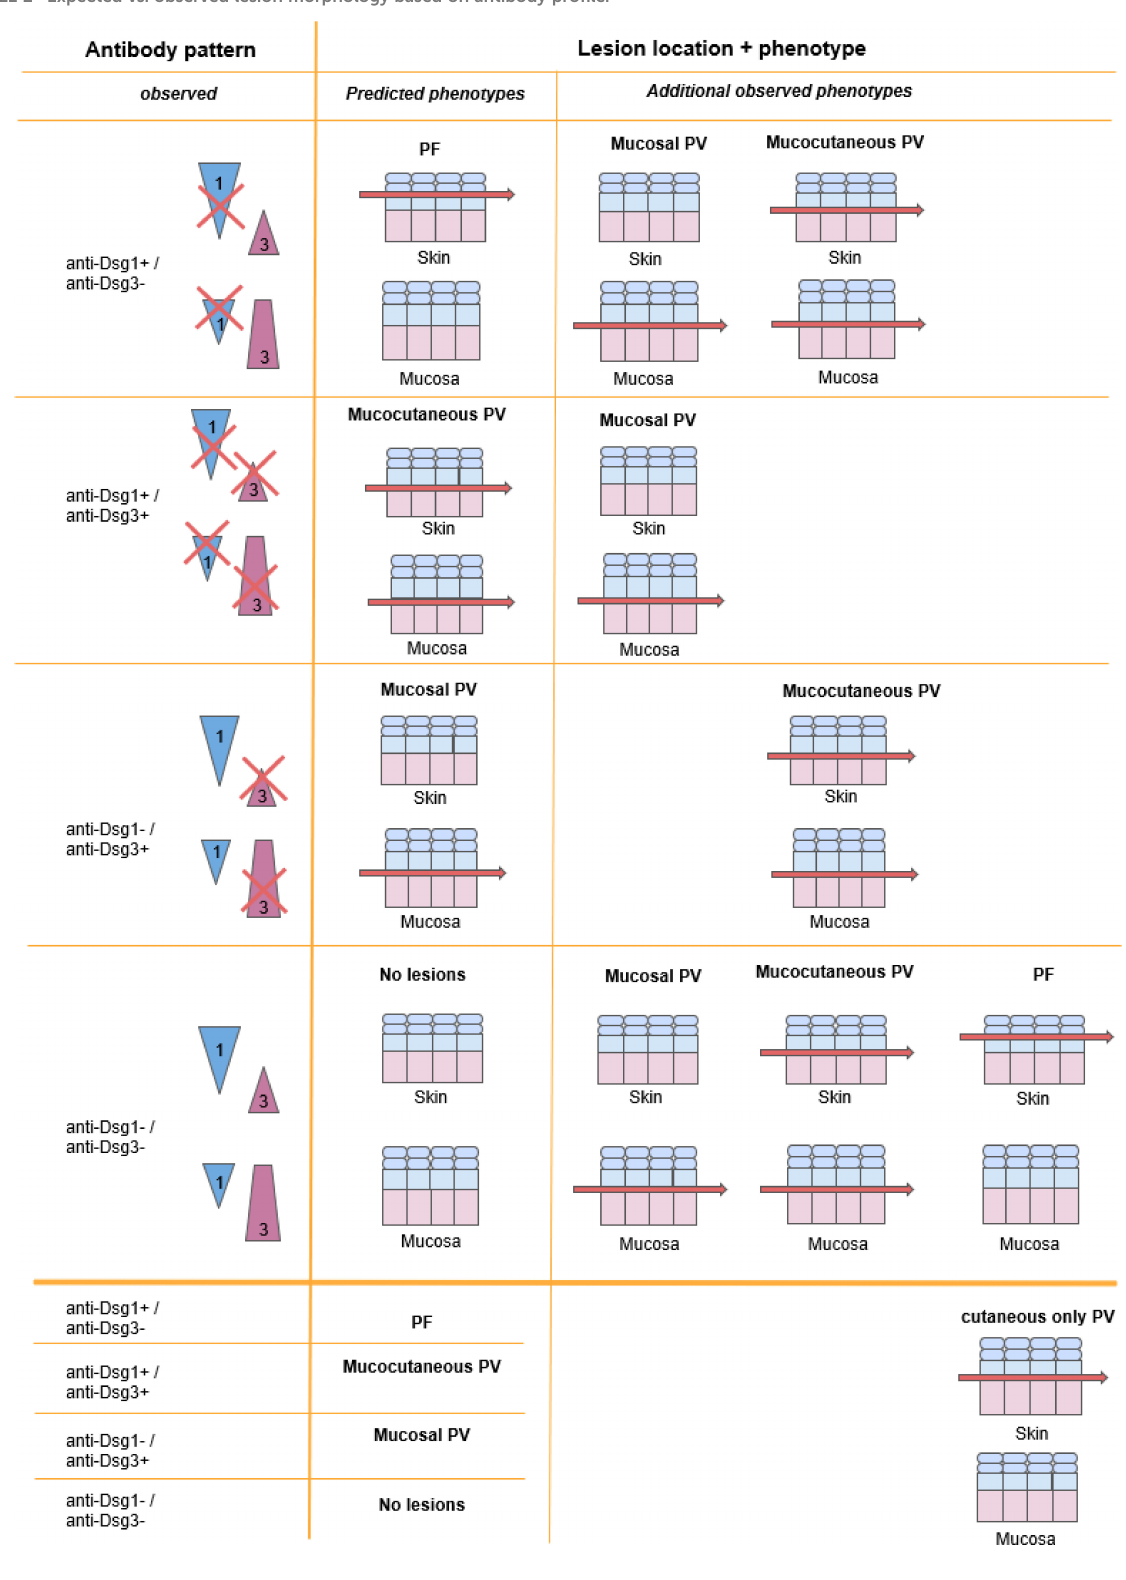
TABLE 2 Expected vs. observed lesion morphology based on antibody pro fi